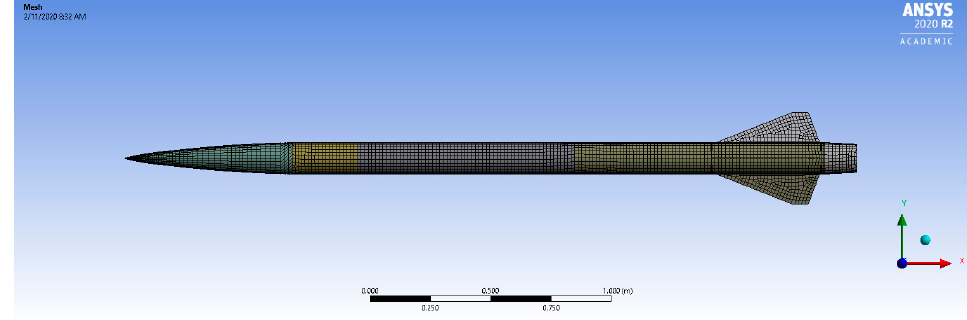
Figure 26. Rocket Mesh.